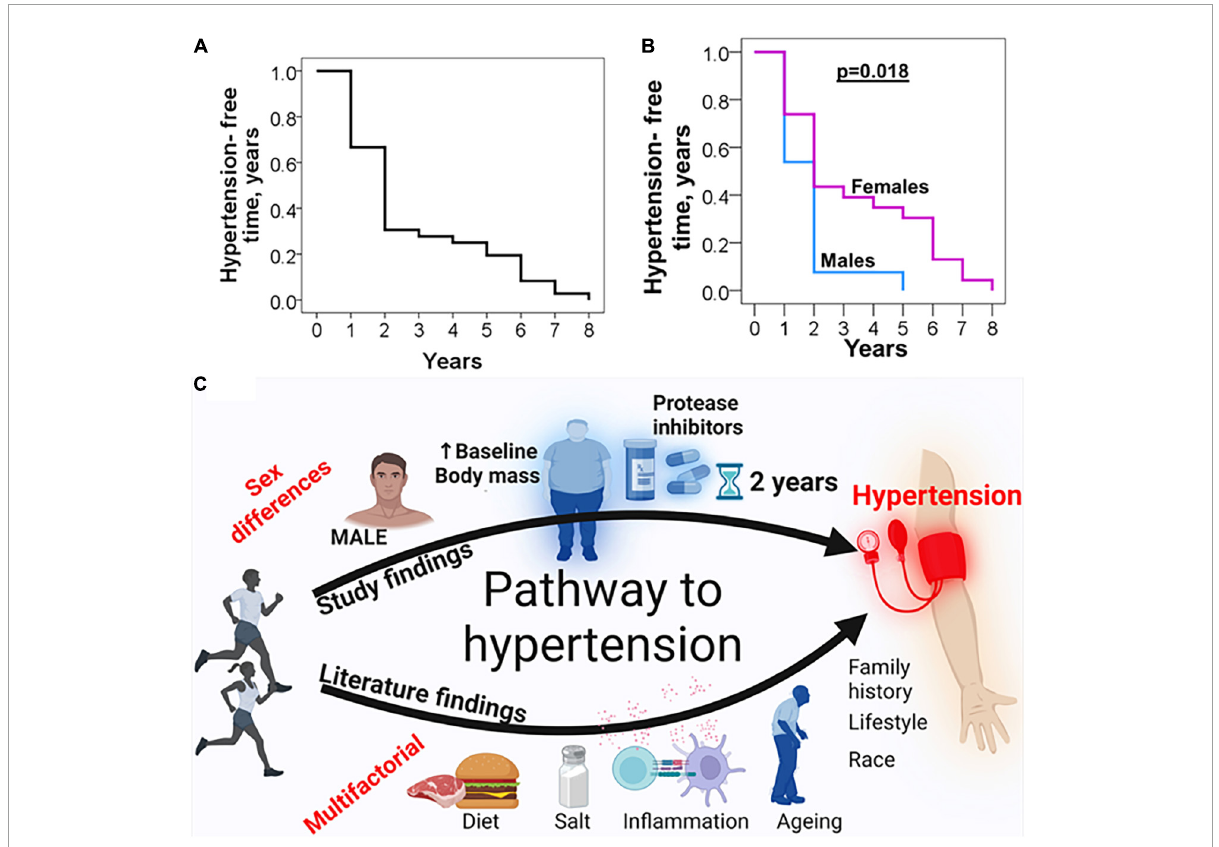
FIGURE6 Sex differences in time course and predictors of incident hypertension. (A) The mean hypertension-free survival time for individuals who developed hypertension was 2.8 years. (B) Sex differences in time course to develop hypertension. Mean hypertension-free time for males was 2 years compared to 6 years for females. (C) Schematic of sex differences in predictors of hypertension (from our study) and general findings from literature on correlates of hypertension in the general